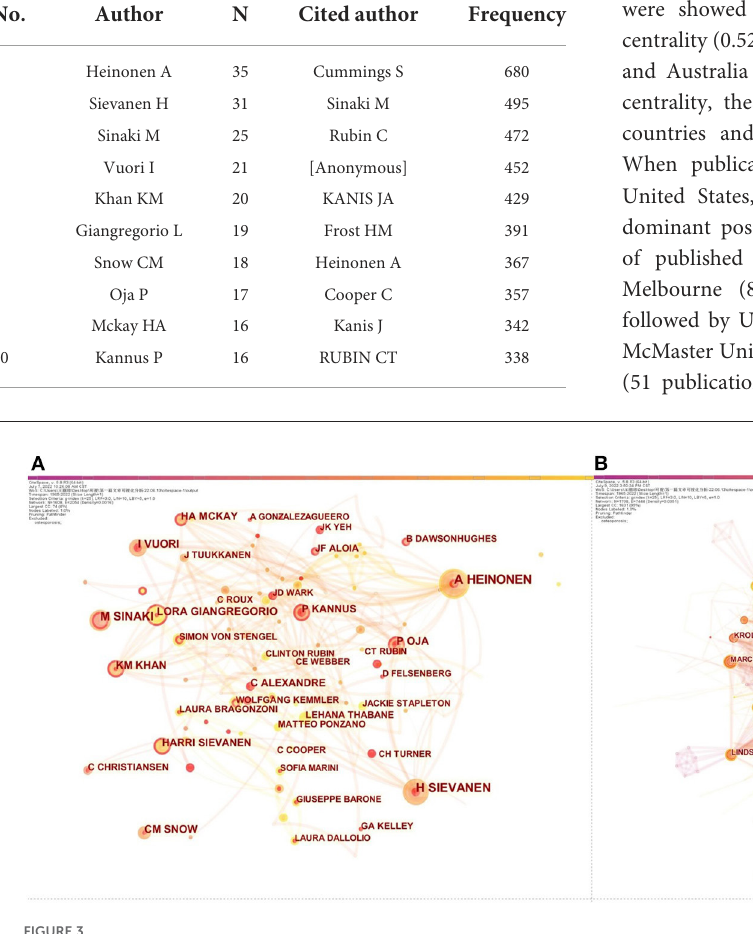
FIGURE3 Network diagram of influential authors (A) ; Network diagram of influential co-cited authors (B) .